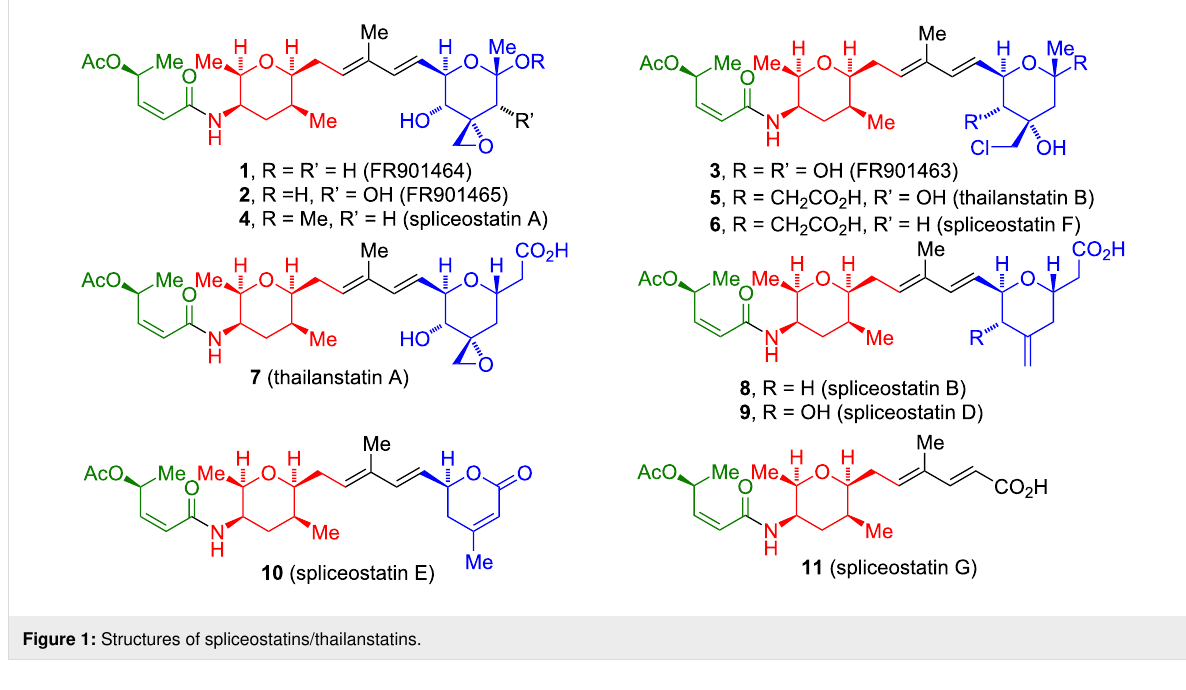
Table 1: Biological activities of spliceostatins/thailanstatins (IC 50 values in nM).